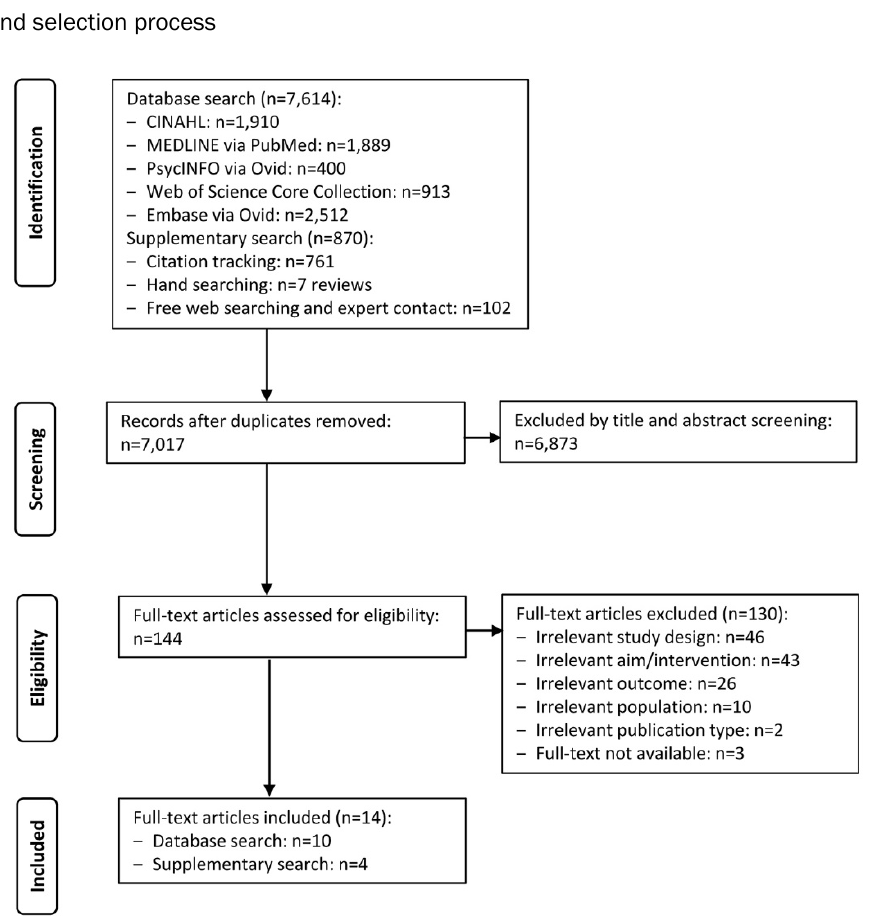
Figure 1 Search and selection